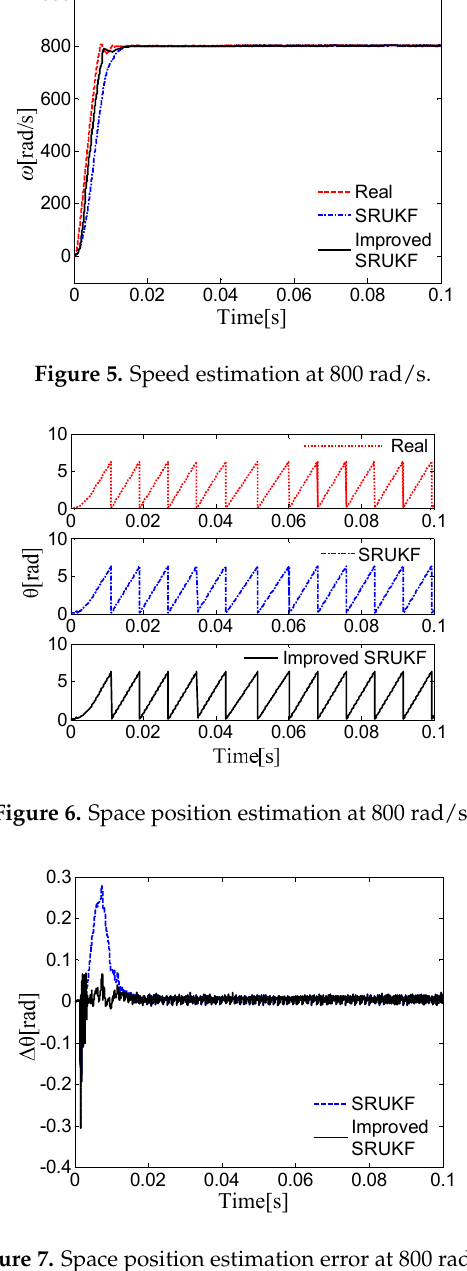
Figure 4. Space position estimation error at 50 rad/s.